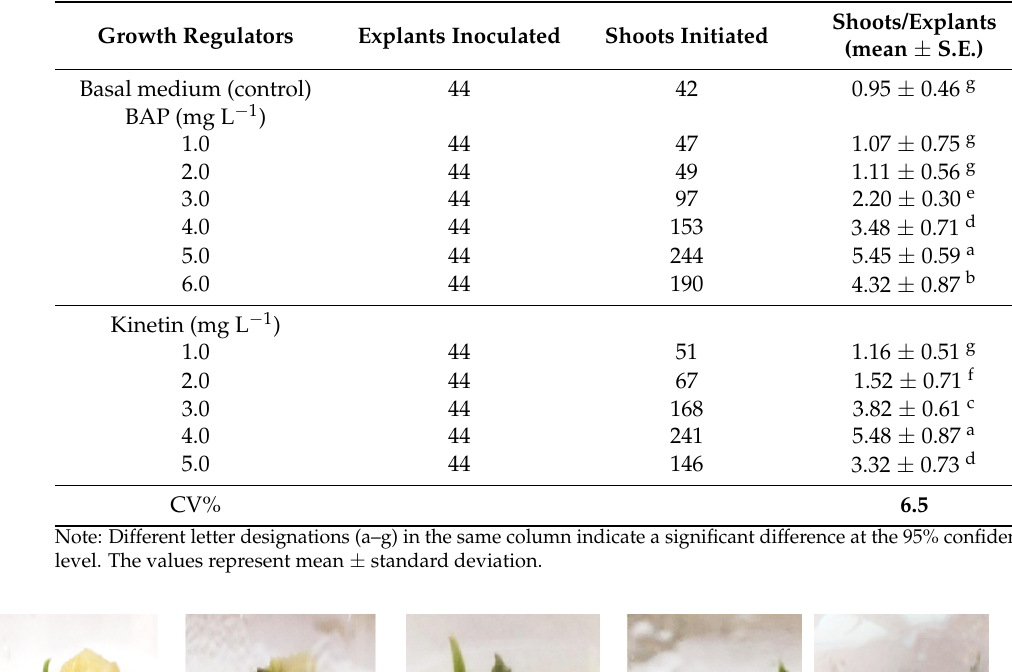
Table 1. Effect of BAP and kinetin concentrations on shoot growth efficiency of S. thorelii Gagnep (second week of culture).